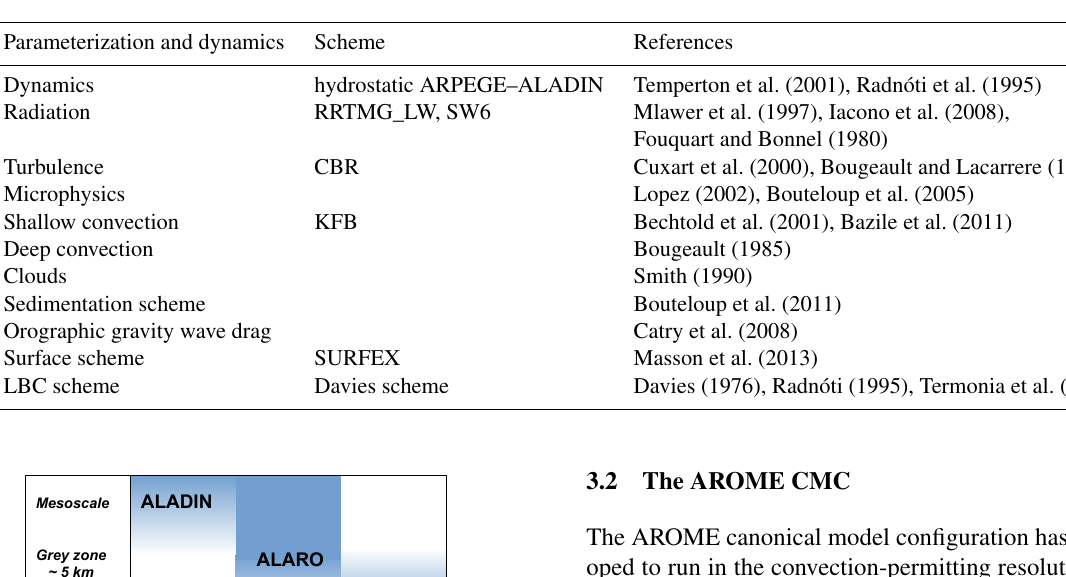
Table 2. The ALADIN CMC.